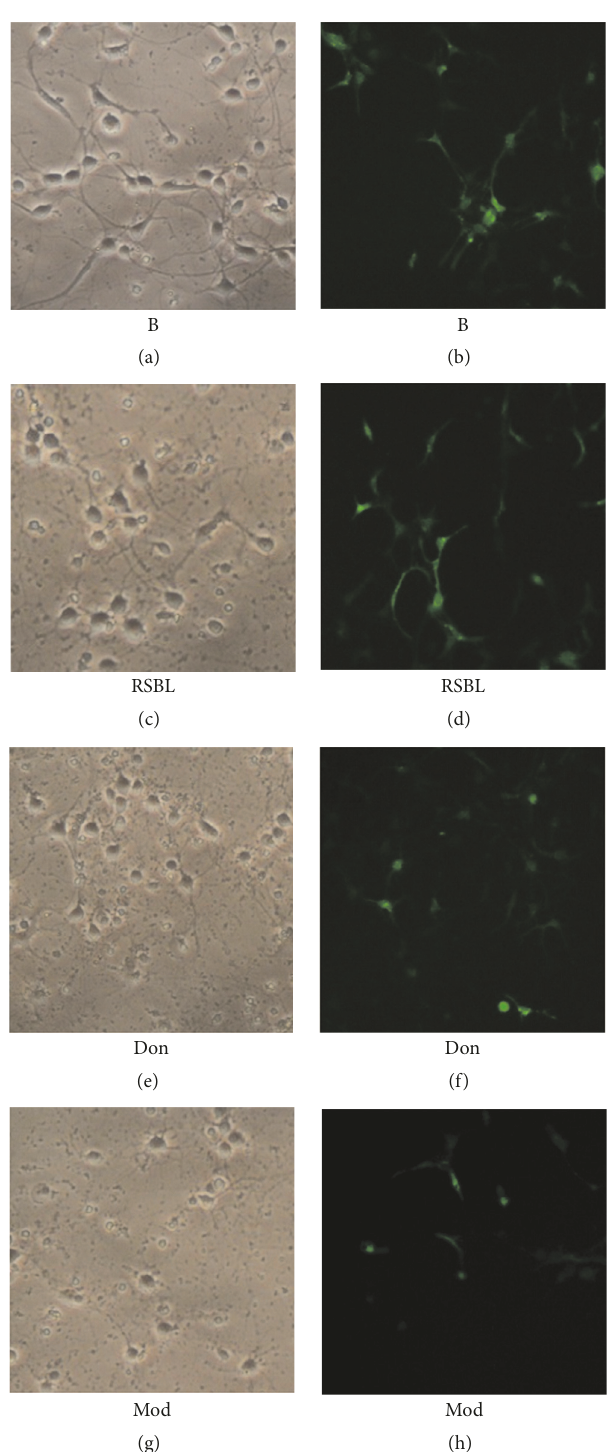
Figure 6: The cell growth status and fluorescence of A 𝛽 1–42-induced hippocampal neurons transfected with pEGFP-C1-CAV1 plasmid after treatments with sera containing RSBFL and